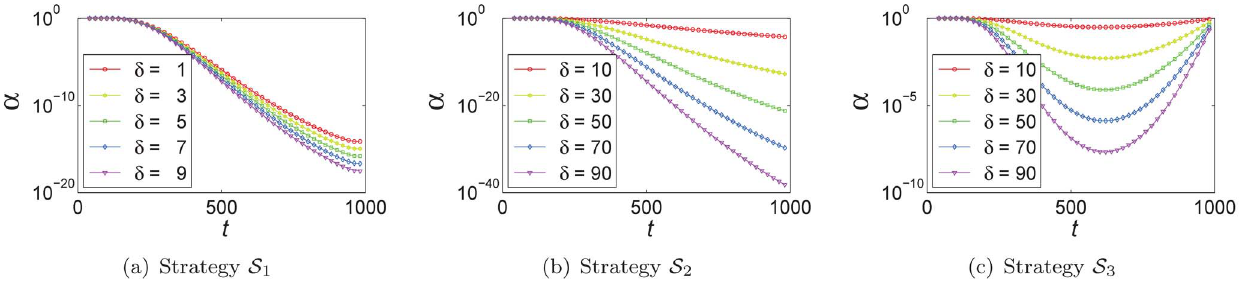
Figure 4. Different strategies for a : (a) strategy S 1 , (b) strategy S 2 , (c) strategy S 3 varying with different d .